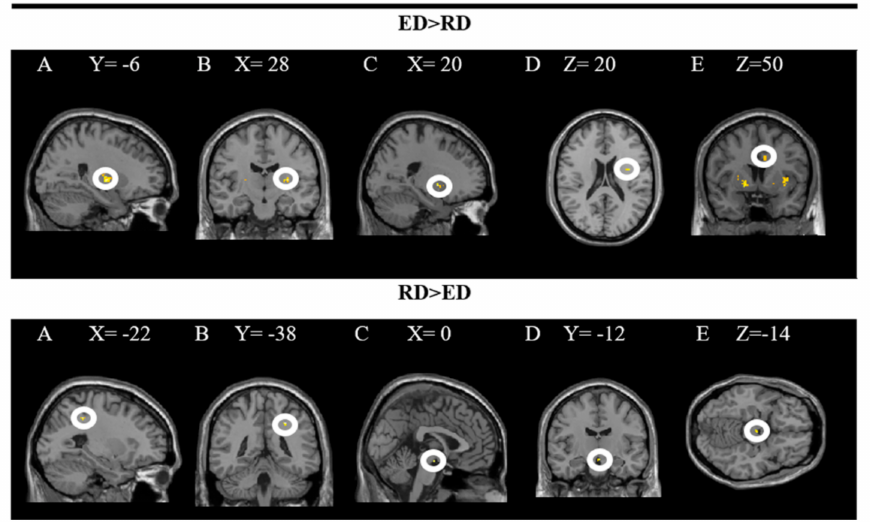
Figure 4. Brain regions activated more strongly to emotional vs. rational description (ED > RD) and rational vs. emotional descriptions (RD >